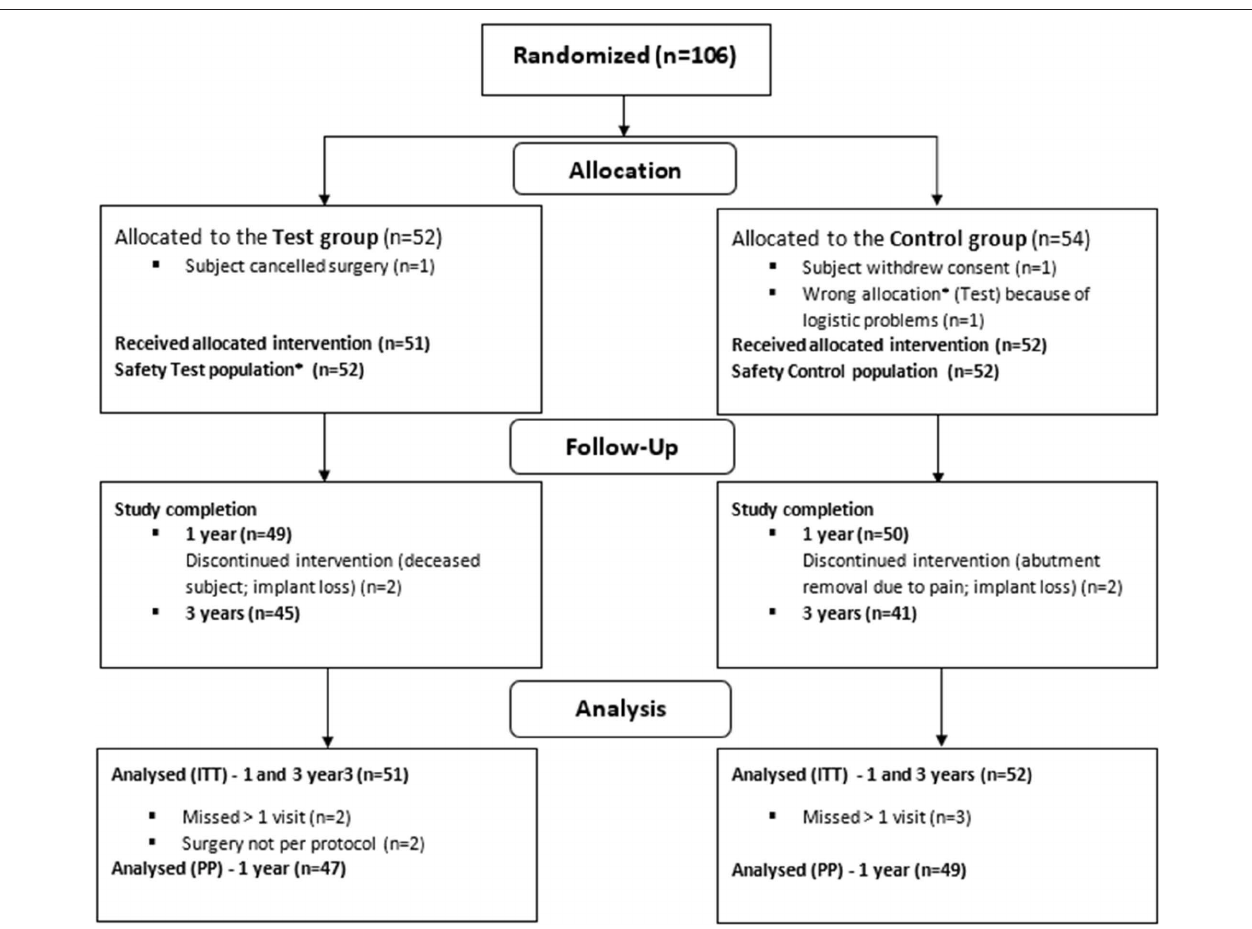
FIGURE 1 | Randomization, treatment and follow-up of subjects. * Due to wrong device allocation in the control group, one subject (randomized to the control group) is considered in the safety population of the test group (23).